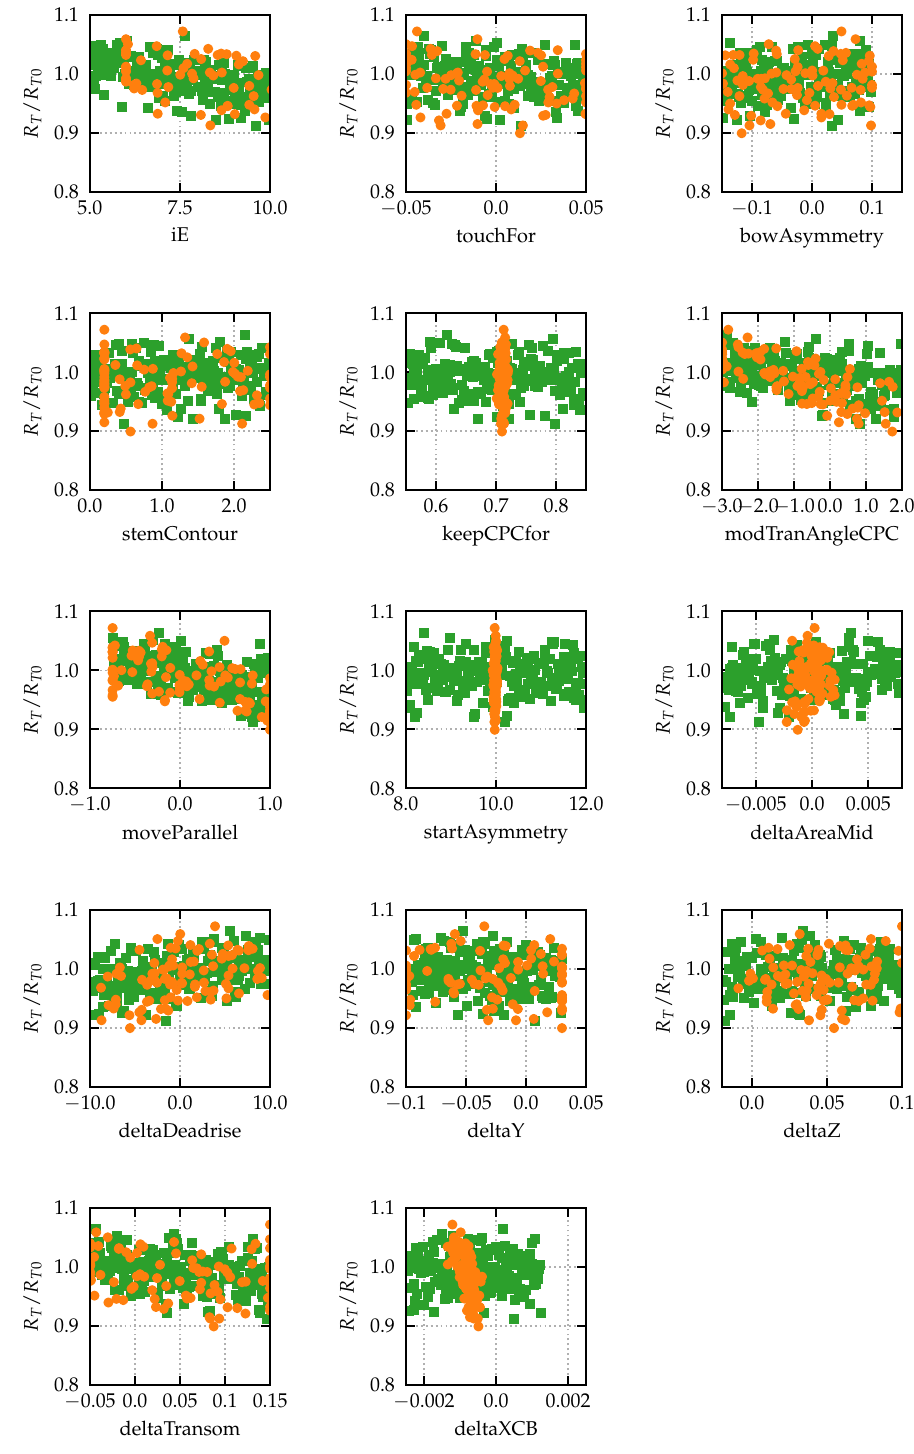
Figure 17. Dependency of the objective function evaluated with XPAN on CAD parameters (green) and on PCA parameters